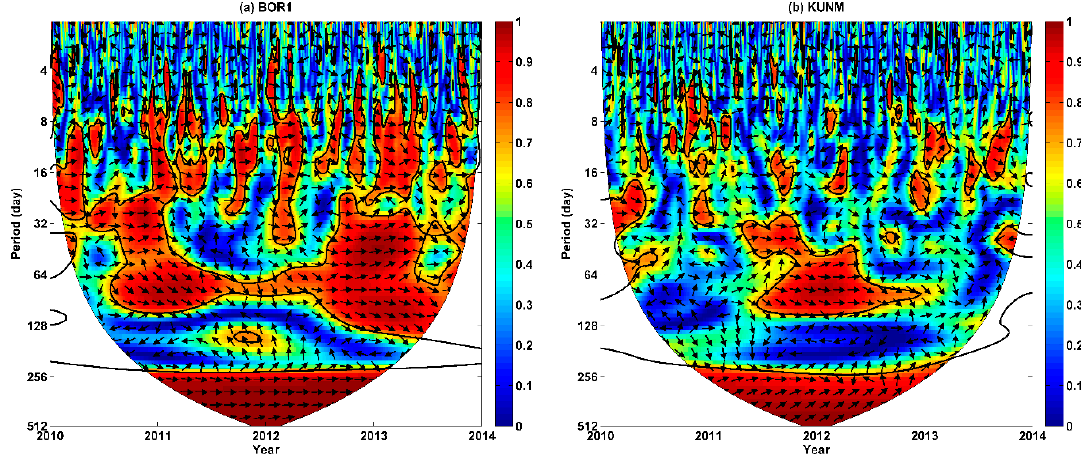
Figure 4. The wavelet coherence (WTC) spectrum of GPS heights and AOH displacements for ( a ) BOR1 site and ( b ) KUNM site.